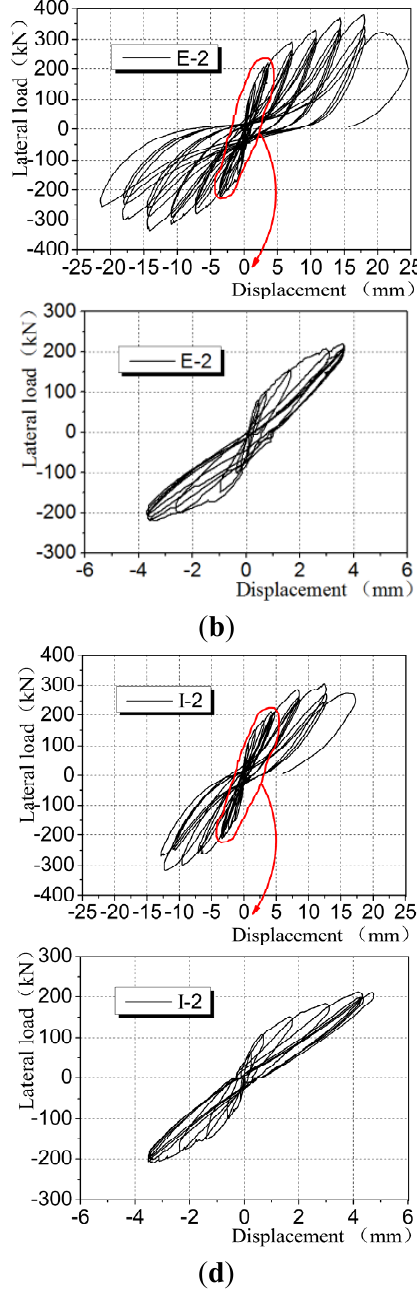
Figure 10. Hysteretic curves for CEW/CIW. ( a ) E-1; ( b ) E-2; ( c ) E-3; ( d )